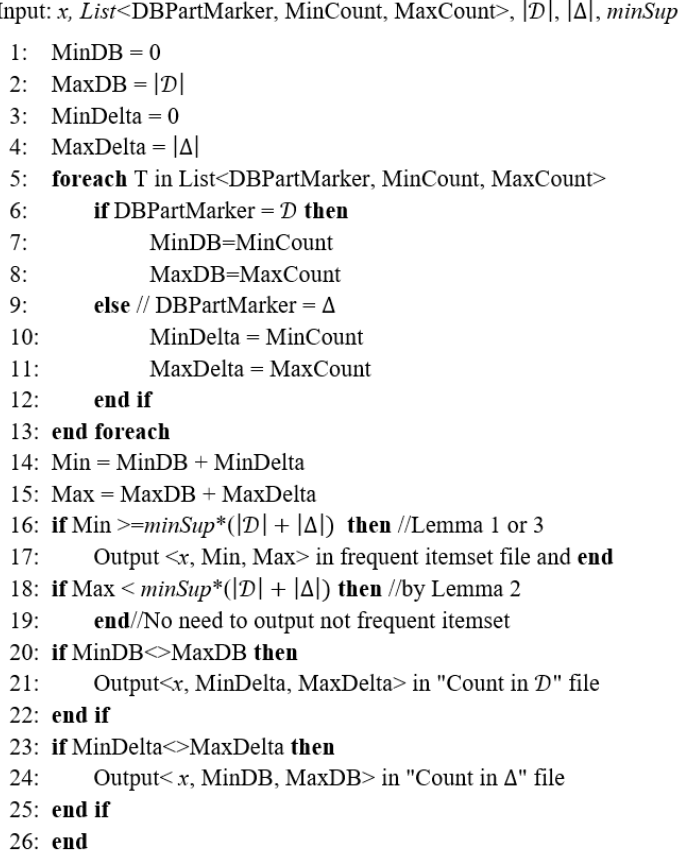
Algorithm 6. The Reducer phase of Join with Lemmas Applied.